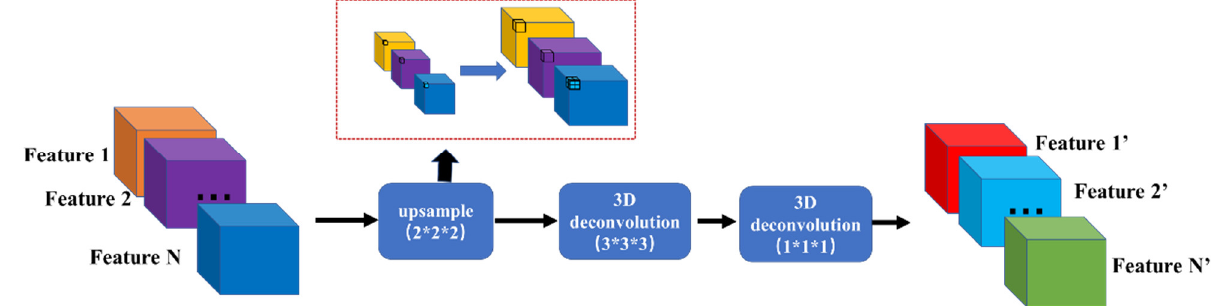
Figure 5. The structure of the generator.